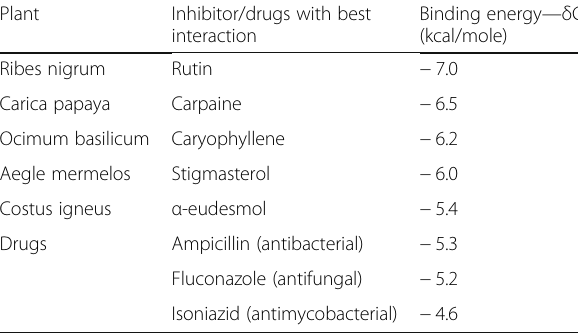
Table 5 Predicted best interaction for Modeled TPP using Autodock